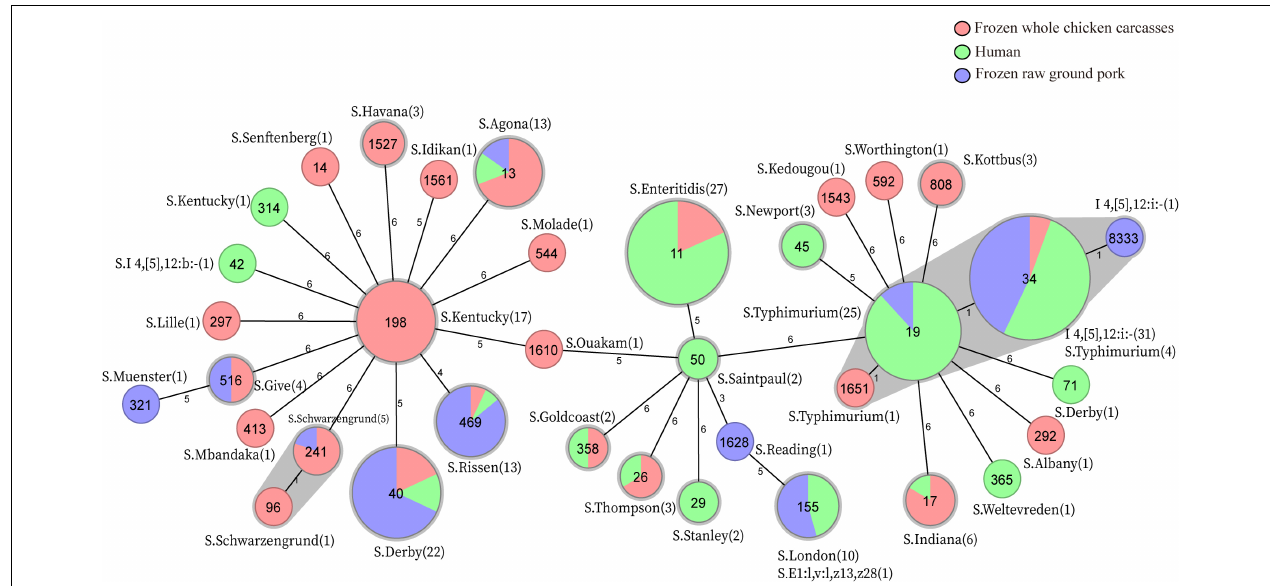
FIGURE 2 | MLST-based Minimum Spanning Tree and in silico serotype distribution of 214 Salmonella , two strains S-3-16 and S-5-8 were excluded due to the presence of the new allele of housekeeping gene hisD and thrA , respectively. The sequence type is represented in the circle. Numbers in brackets indicate the number of strains corresponding to the in silico serotype.